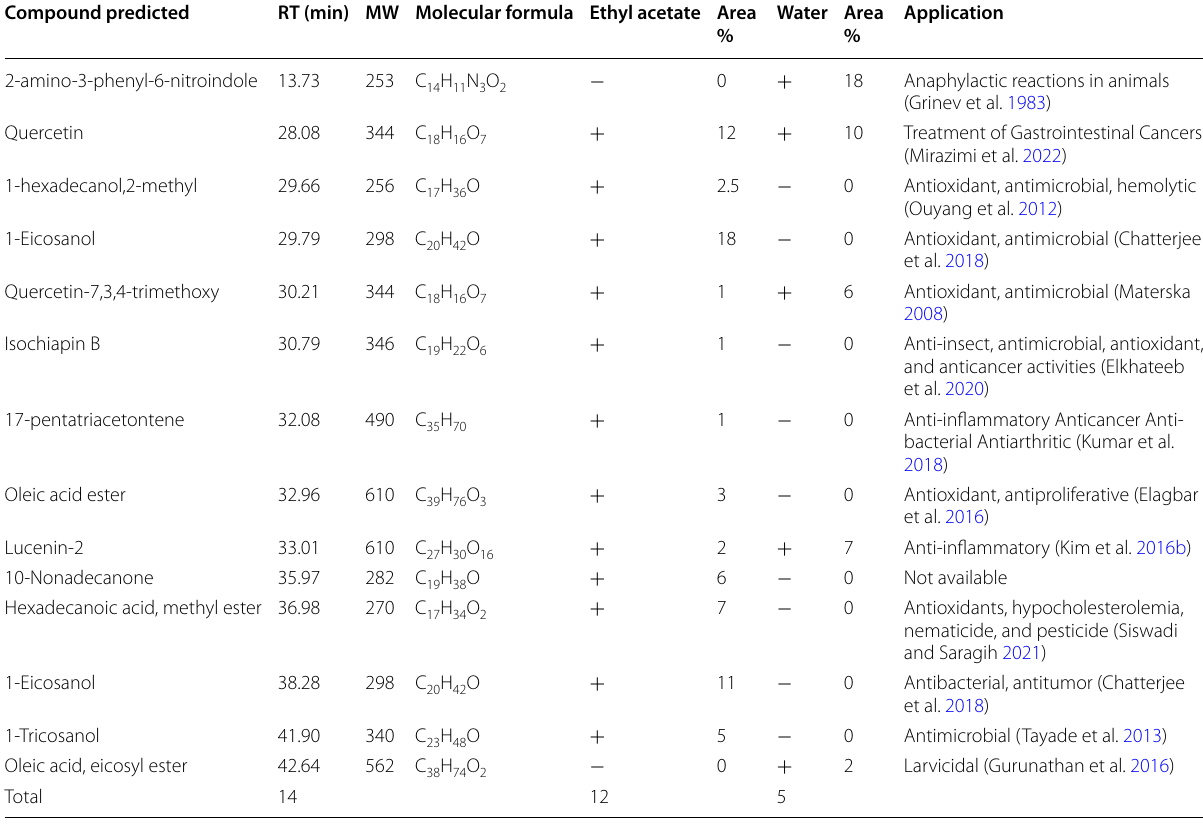
Table 8 Preliminary identification and distribution of the subcomponents of the aquatic and ethyl acetate extracts by GC–MS Compound